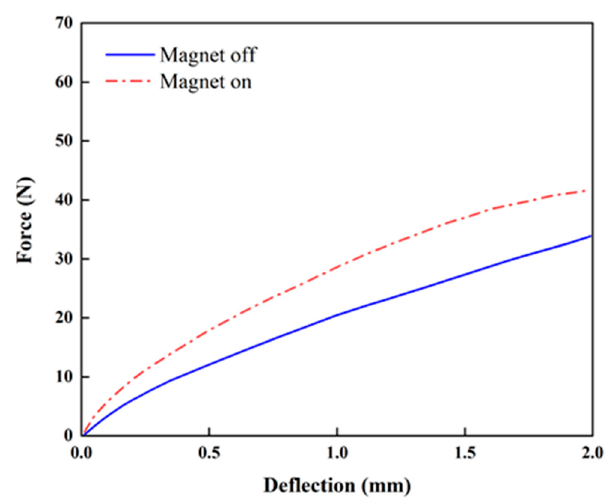
Figure 10. Sti ff ness variation of specimen 2 (top–bottom PM configuration, Figure Figure 10. Stiffness variation of specimen 2 (top–bottom PM configuration, Figure 6d).